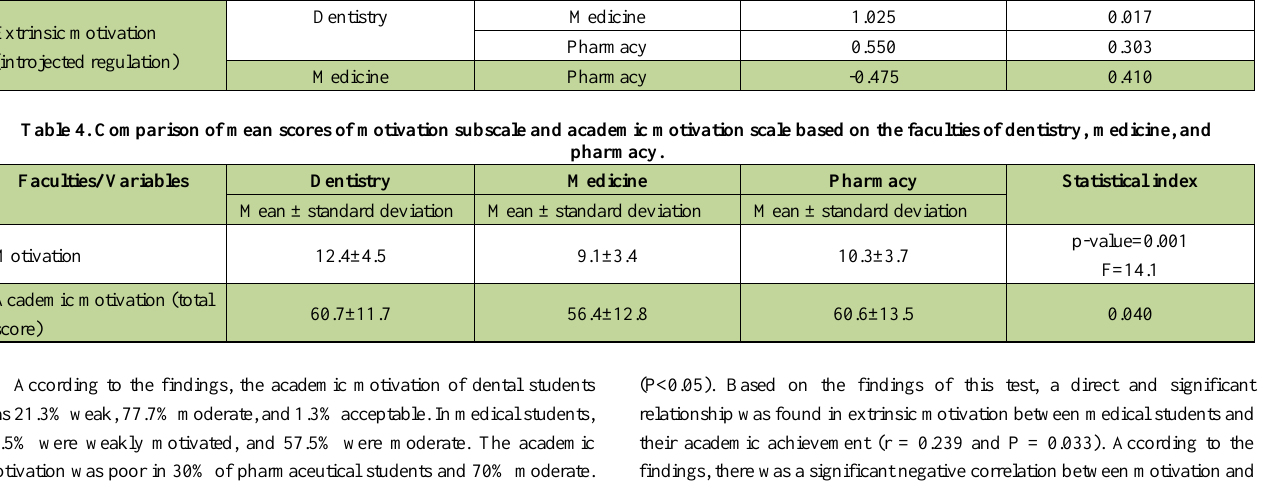
Table 3. Pairwise comparison of mean scores of intrinsic motivation subscales based on faculty using Tukey test. Variables